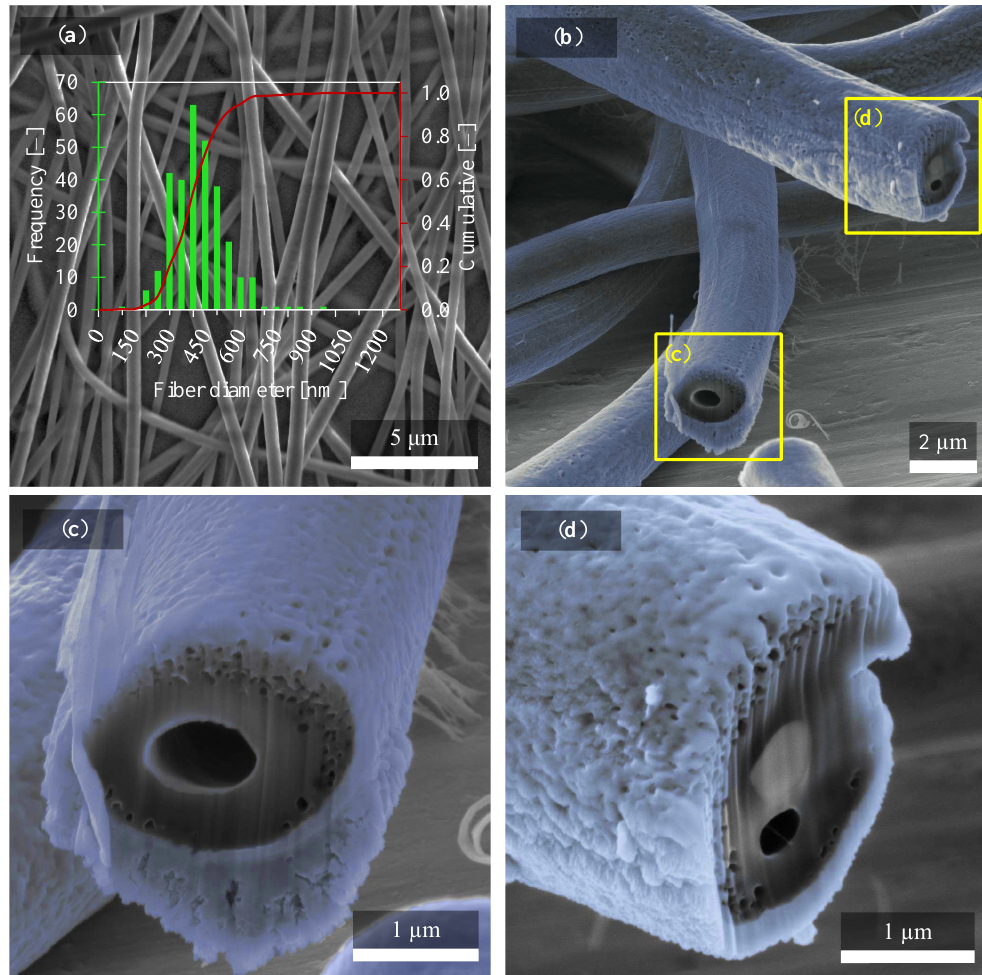
Figure 3. ( a ) SEM image of PVDF fibers prepared at 2000rpm with ( b ) detail of PVDF nanofiber in cross-section and its porous structure after fabrication with 2000rpm of collector speed. All four figures describe the same fiber structure. The cross-section focused from ( b ) to the detailed part of the individual fibers ( c , d ). Please note that the range of x-axis in ( a ) is half of the range of histogram used in Figure